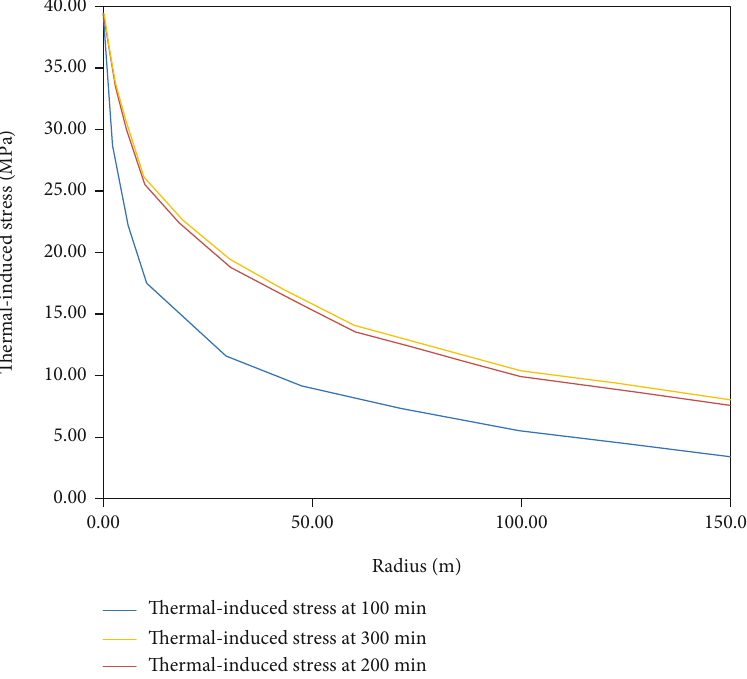
Figure 4: Thermal-induced stress during